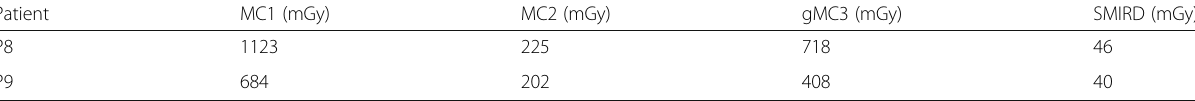
Table 4 Comparison of bone marrow absorbed dose estimates based on Monte Carlo simulations for patients 8 and 9 Patient MC1 (mGy) MC2 (mGy) gMC3